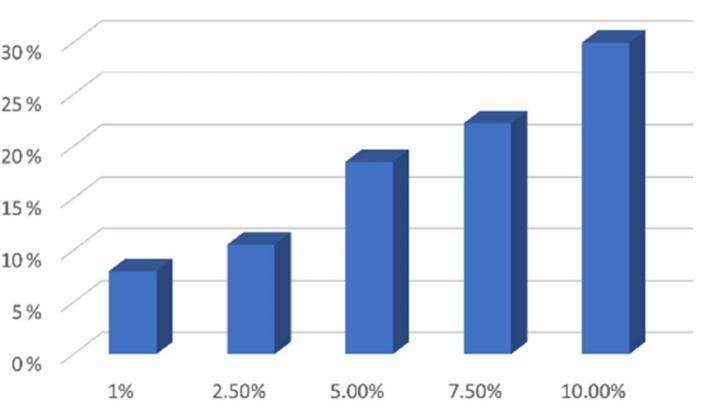
Figure 5. Whitening improvement rates of the fermentation solutions at different concentrations after 28 days of use.